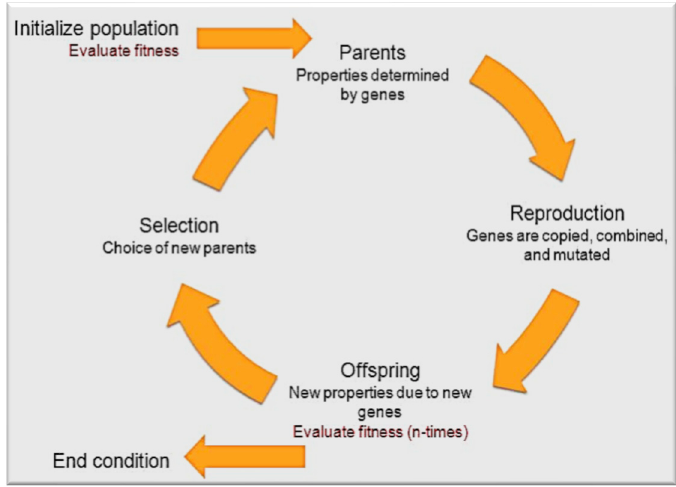
Figure 5. GA three steps: Selection, cross-over, and mutation are involved in creating the evolution from one generation to the next.